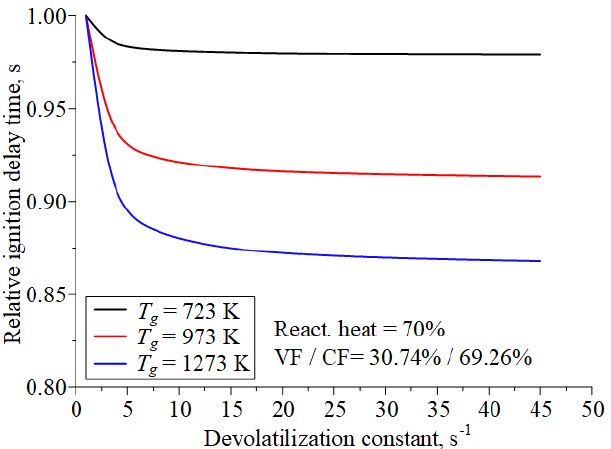
Figure 6. Relative ignition-delay times of CLF No. 4 (FC 90% + plastic 10%) vs. devolatilization constant of the combusting particle at different temperatures of the radiant heating source.